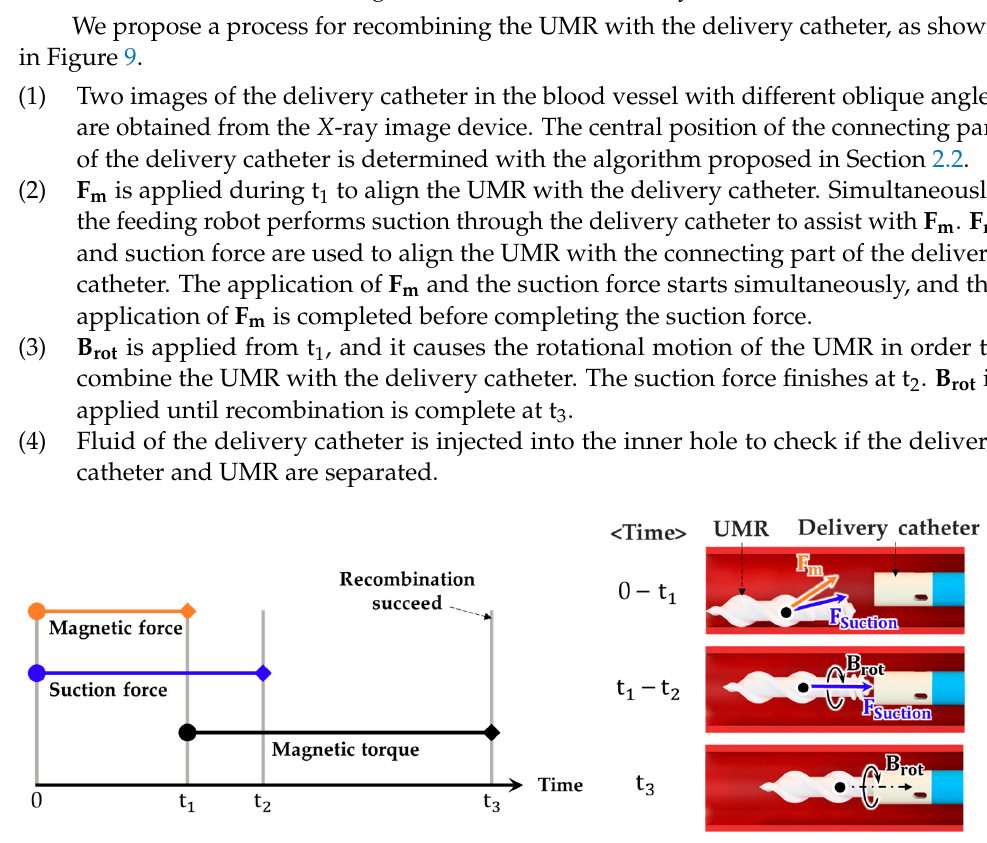
Figure 9. Procedure for recombining the UMR with the delivery catheter by applying magnetic force F m , a rotational magnetic field B rot , and suction force to the UMR.